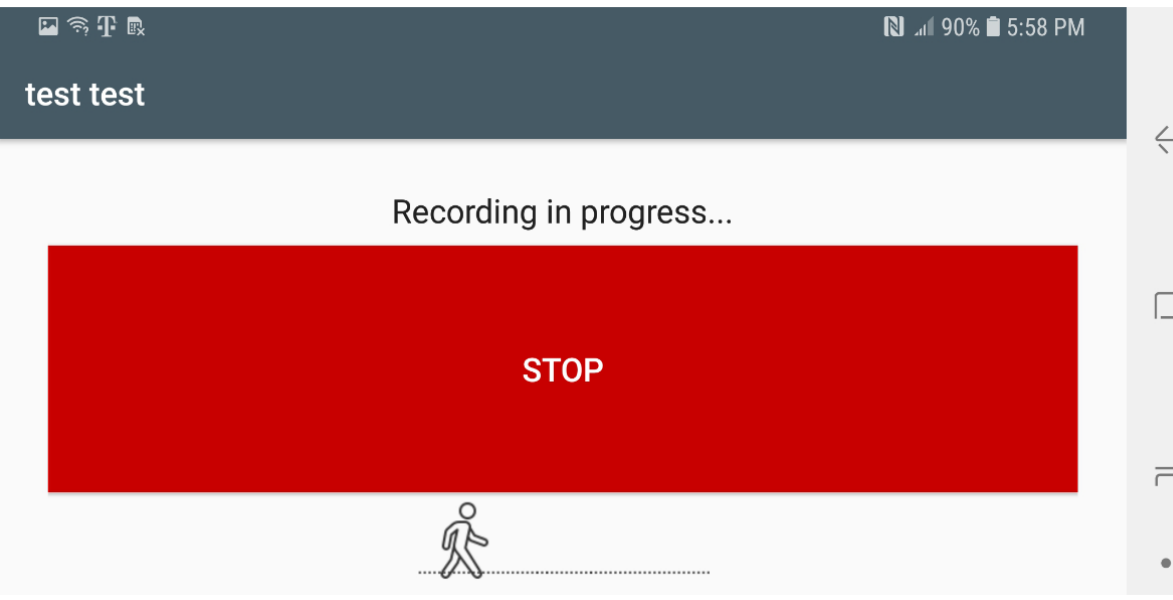
Figure 3. Stop fragment of the mobile health